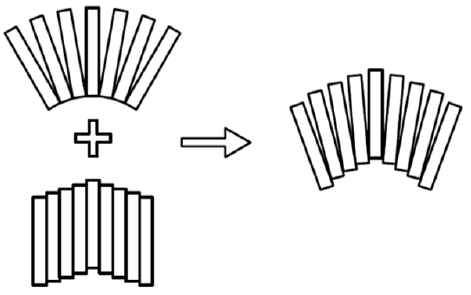
Figure 5. The schematic diagram for the collaborative deformation mode of a shield tunnel [13]. As shown in Figure 6, the total relative displacement between adjacent ring segments numbered m and m + 1 is δ x , the relative horizontal displacement induced by the rigid rotation is δ x1 , and the relative horizontal displacement caused by the dislocation is δ x2 . Then, it satisfies the equation δ x = δ x1 + δ x2 . Set δ x1 = j x δ x , where j x is the proportionality coefficient for the rotation effects of the segment rings. When j x = 0, there is no relative rota- tion between adjacent segments. It is consistent with the deformation model of dislocation proposed by Zhou et al. [21]. When j x = 1, the horizontal displacement is completely caused by the rotation of adjacent segments, which is the deformation mode of complete